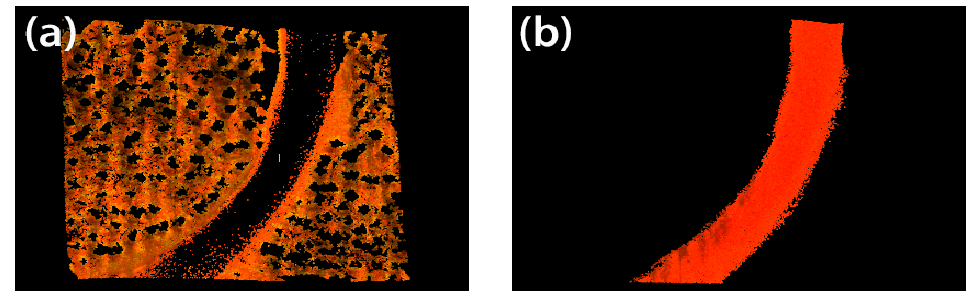
Figure 30. The ski-track was extracted from the Figure 26b: ( a ) is non-ski-track points; ( b ) is ski-track